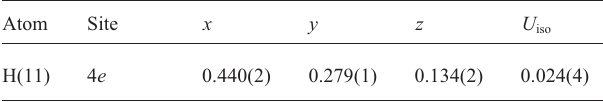
Table 2. Atomic coordinates and displacement parameters (in Å 2 ) .